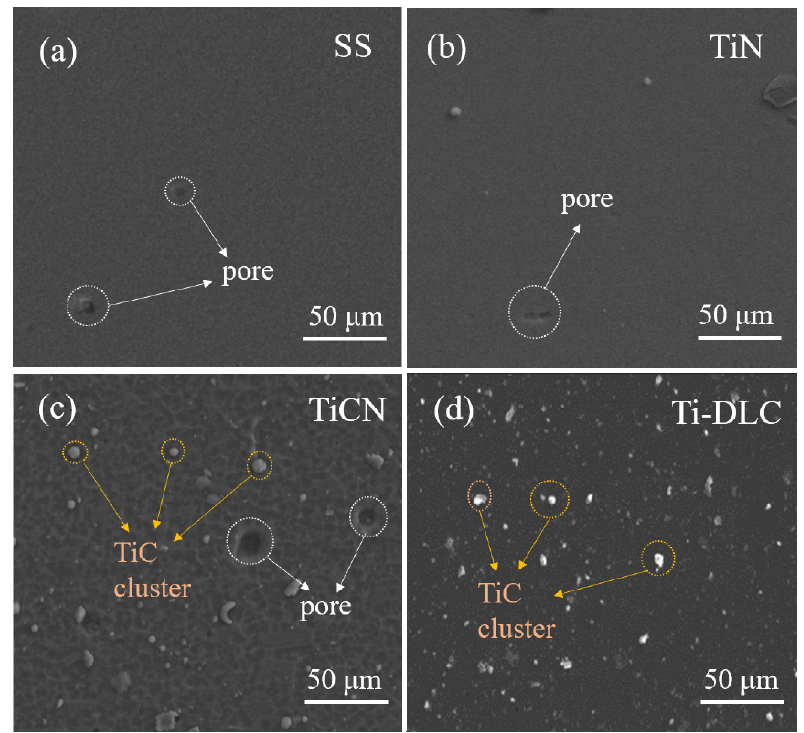
Figure 1. SEM images of the surfaces of ( a ) SS; ( b ) TiN; ( c ) TiCN; ( d ) Ti-DLC.